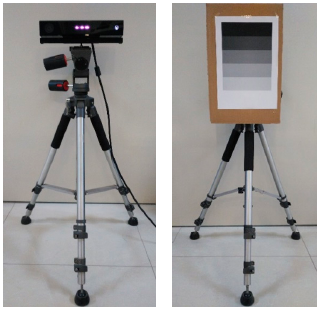
Figure 5. Setup of the method: Kinect v2 ( left ); stripe plane pattern ( right ).